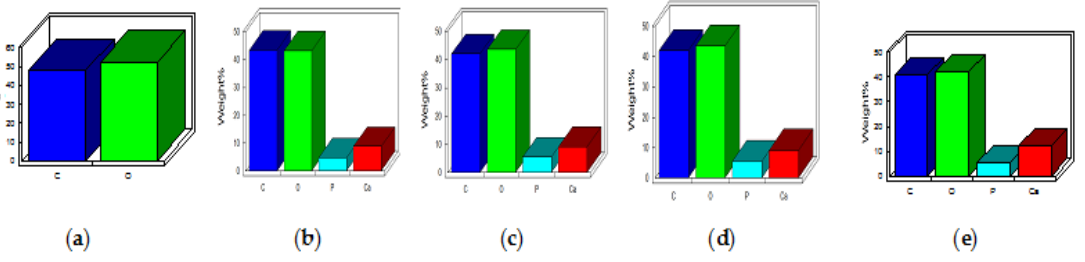
Figure 6. EDAX analysis of ( a ) HPC/PLA ( b ) 40:60 ( c ) 50:50 ( d ) 60:40 ( e ) 70:30 of HAP-HPC/PLA. Table 5. The calculated Ca/P Ratio from EDAX Analysis. S.No.